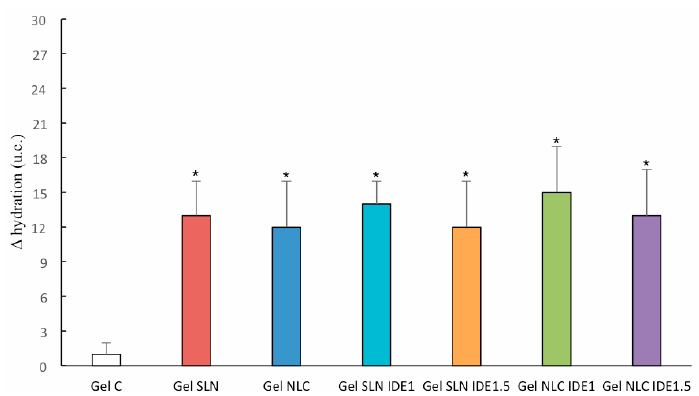
Figure 7. Differences in skin hydration values ( ∆ hydration) obtained after a two-week in vivo topical treatment with the gels under investigation. Statistical analysis for the comparison: * p < 0.05 vs. gel C. Gel C = control gel (without lipid nanocarriers), Gel SLN = gel containing unloaded solid lipid nanoparticles (SLN), Gel NLC = gel containing unloaded nanostructured lipid carriers, Gel SLN IDE1 = gel containing idebenone (IDE) 1% w/w loaded SLN, Gel IDE1.5 = gel containing IDE 1.5 % w/w loaded SLN, Gel NLC IDE1 = gel containing NLC loaded with IDE 1% w/w, Gel NLC IDE1.5 = gel containing NLC loaded with IDE 1.5 %